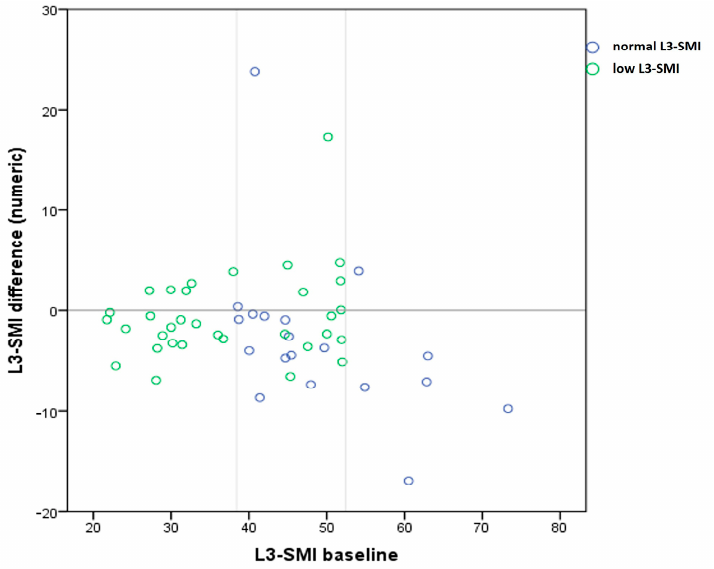
Figure 4. Scatter plot for L3-SMI difference after SVR in the baseline groups with low L3-SMI and normal L3-SMI. The difference in evolution is illustrated by the small number of patients in the group with initially normal values who showed an increase in L3-SMI values after SVR (above the zero line) compared to patients with low baseline